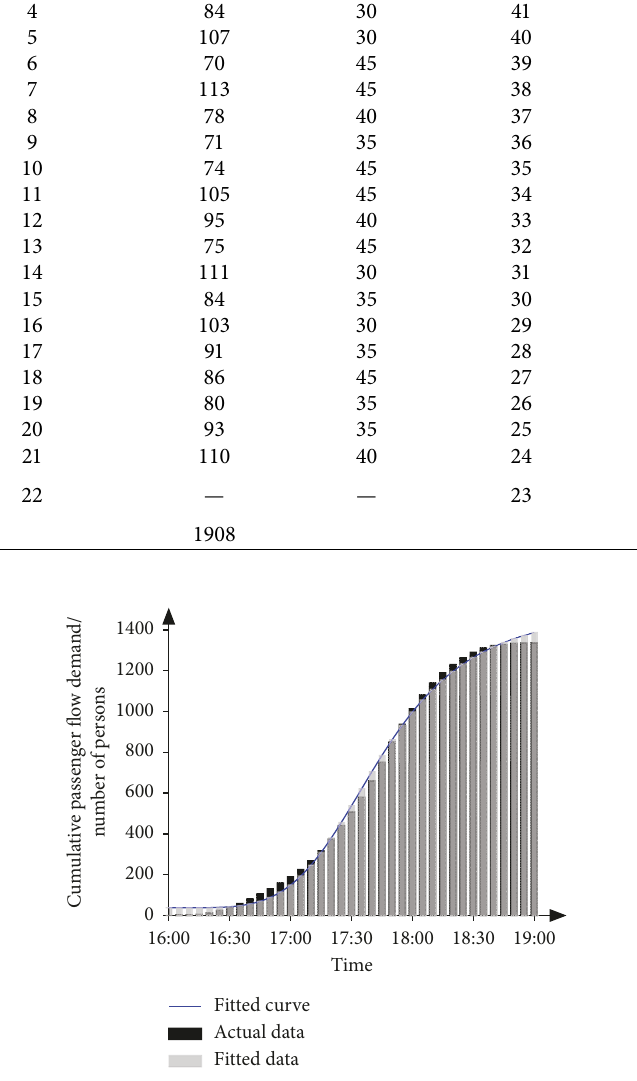
Figure 5: The fitted curve and actual data of the cumulative passenger flow